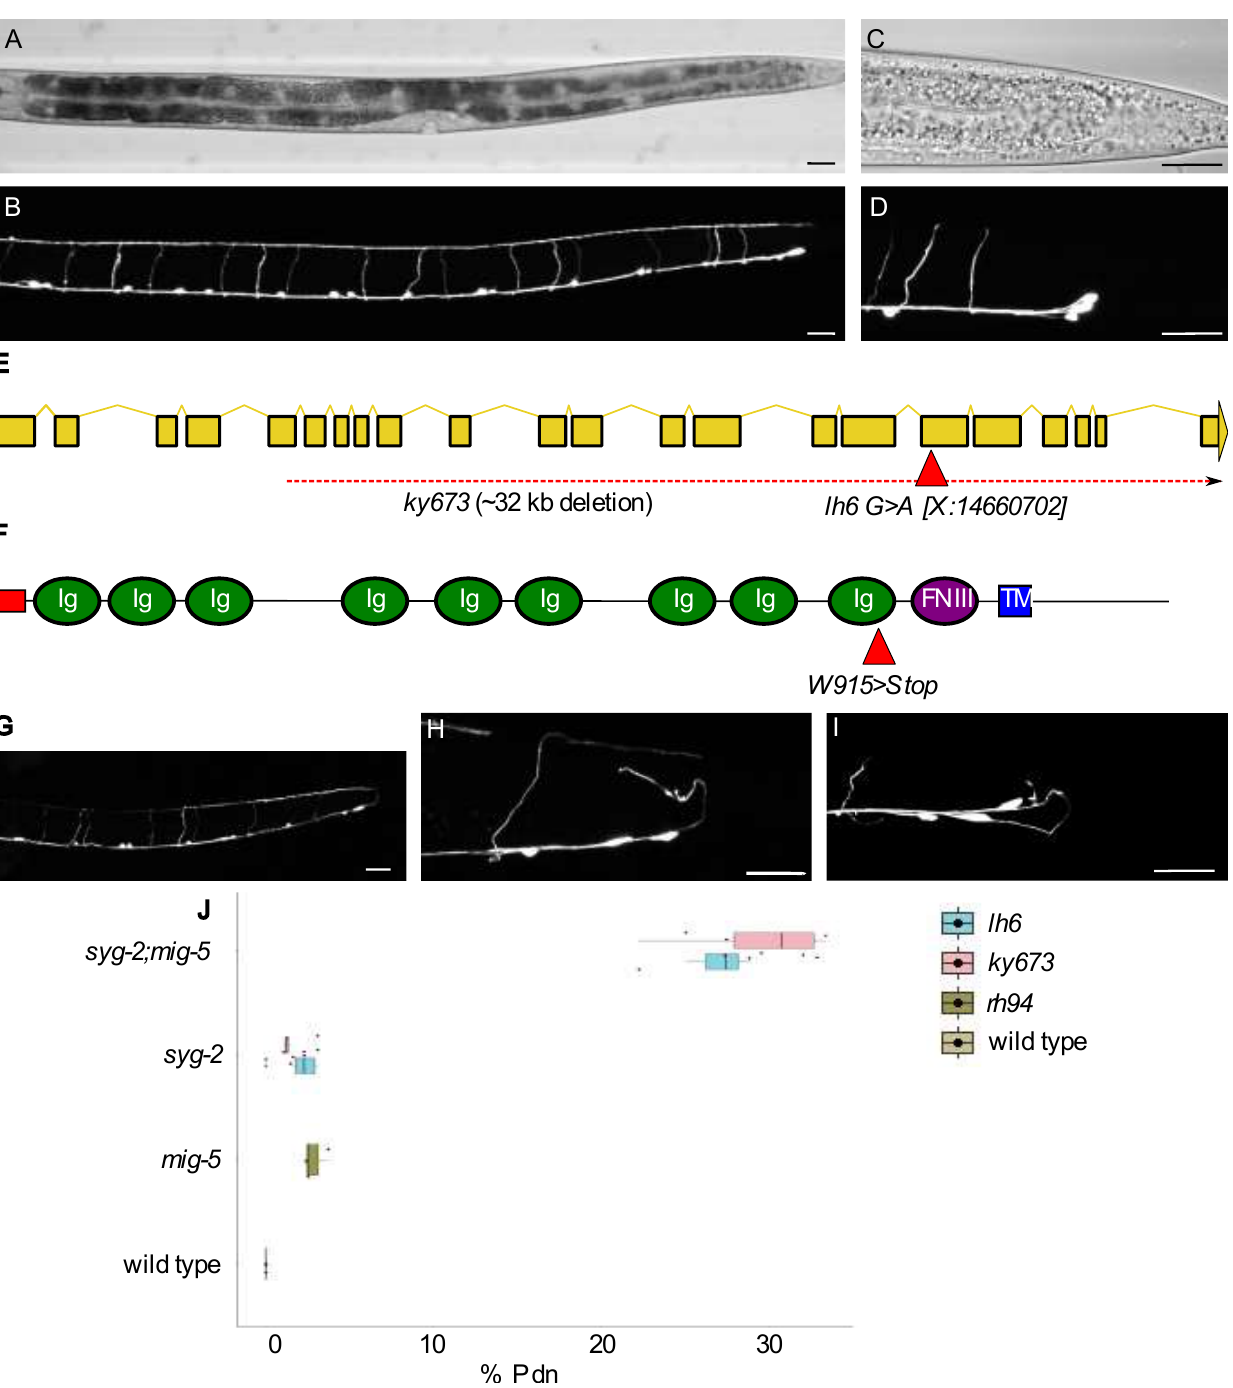
Figure 1. syg-2 mutants exhibit posteriorly directed neurites (Pdns). ( A , B ) A wild-type juIs76 animal (( A ) — transmitted light) and GFP (( B ) — GFP). For all images, anterior is left and dorsal is upward, and scale bars = 20 μm. The DD and VD neurons form a ladder-like presentation, with regularly spaced commissures forming the rungs ( B ). ( C , D ) In the posterior region of the animal, four D-type neurons are visible. At the end of the ventral nerve cord are the VD12, DD6 and VD13 neurons in a cluster. Note that no processes extend to the posterior of this cluster. ( E , F ) A schematic of the syg-2 gene ( E ) and protein ( F ), with the location of the lh6 mutation indicated. ( G , H , I ) Pdns in syg-2(lh6), syg-2(ky673) and syg-2(lh6) ; mig-5(rh94) mutants are presented, respectively. ( J ) Boxplot of the percentage of animals observed with Pdns by genotype.